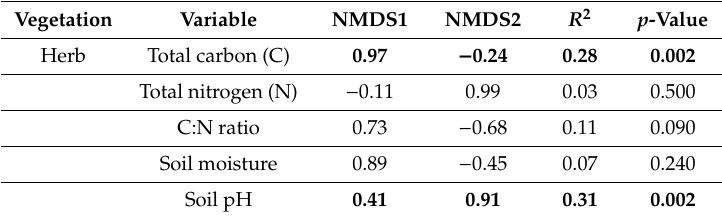
Table 4. Nonmetric multi-dimensional scaling (NMDS) showing the associations between the composition of herbs and shrubs and soil variables. The significant relationships are in bold, and R 2 is the fit index of the